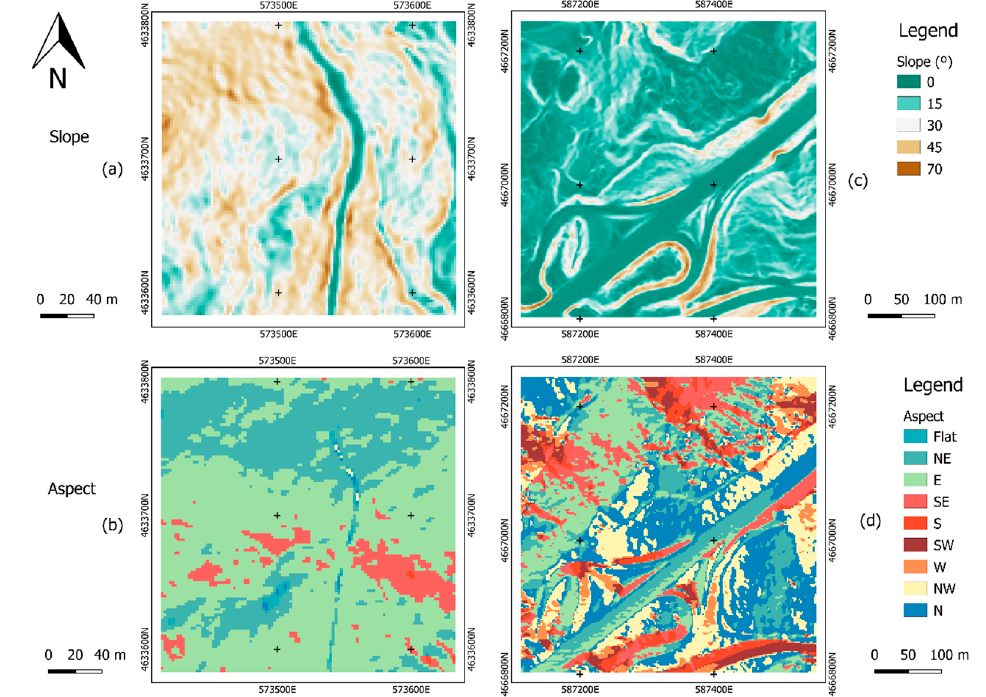
Figure 3. Slope and aspect maps. ( a ) Slope map of study area A; ( b ) aspect map of study area A; ( c ) slope map of study area B; ( d ) aspect map of study area B. The map coordinate system is EPSG:25829 ETRS89/UTM zone 29N.